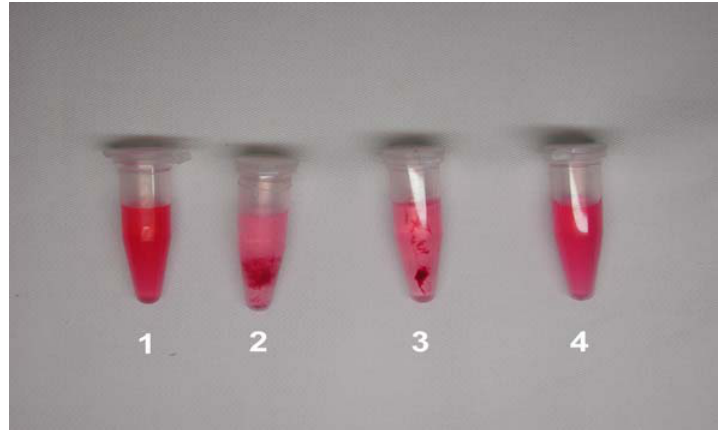
FIGURE 4 - Conic tubes (1,8 ml) with the steps of collagen mensuration with chromogenic precipitation reaction with dye Sirius Red . (1) addition of dye, (2) 30 minutes after addition of dye, with filaments (complex collagen-dye) in red, (3) post-centrifugation, with complex collagen-dye precipitated in the bottom of the tube, (4) post-elution with KOH 0,1 N